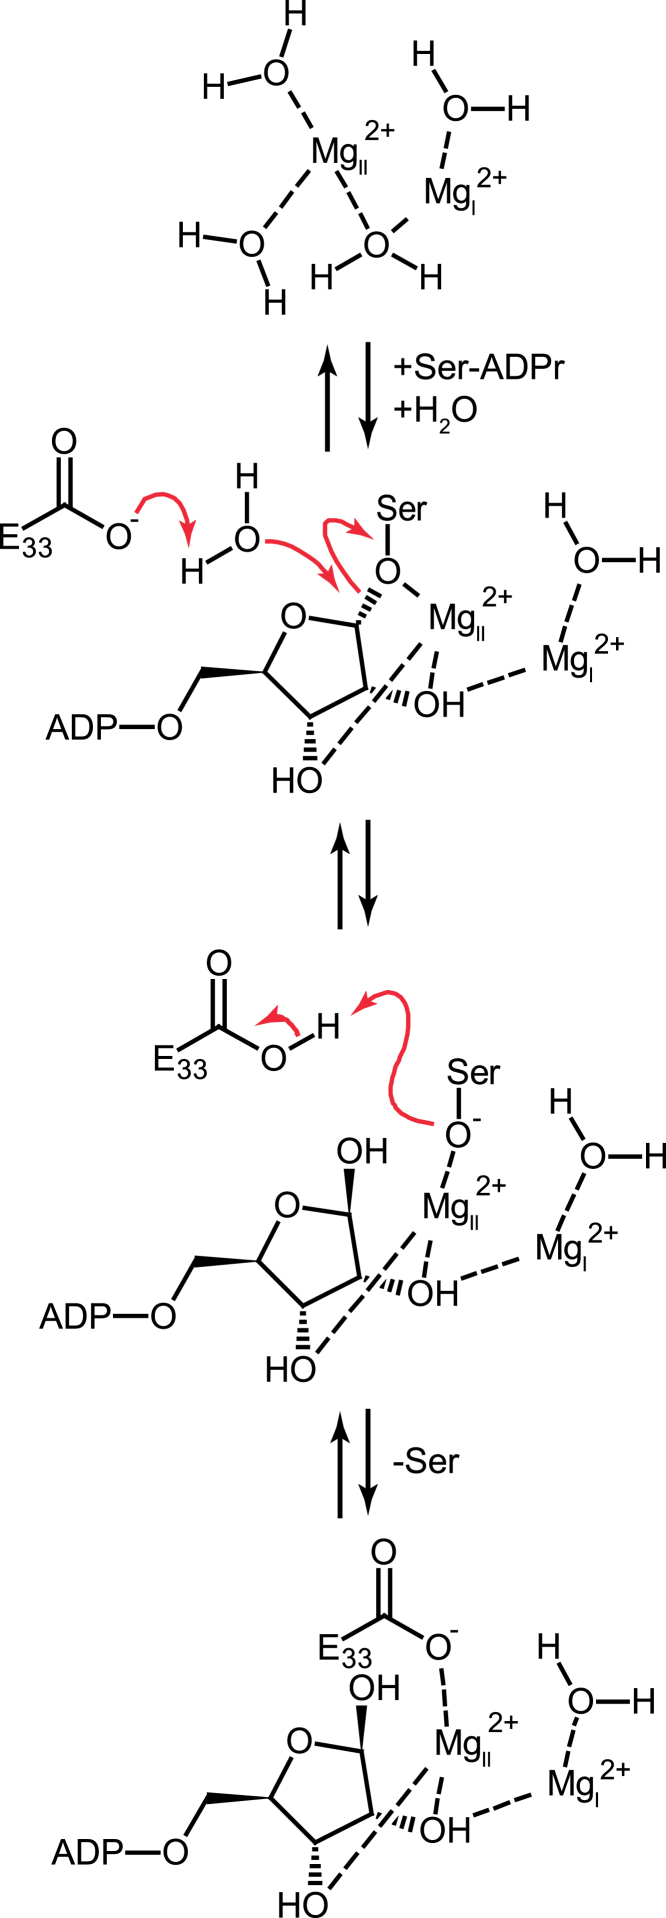
Proposed Reaction Mechanism for ARH3